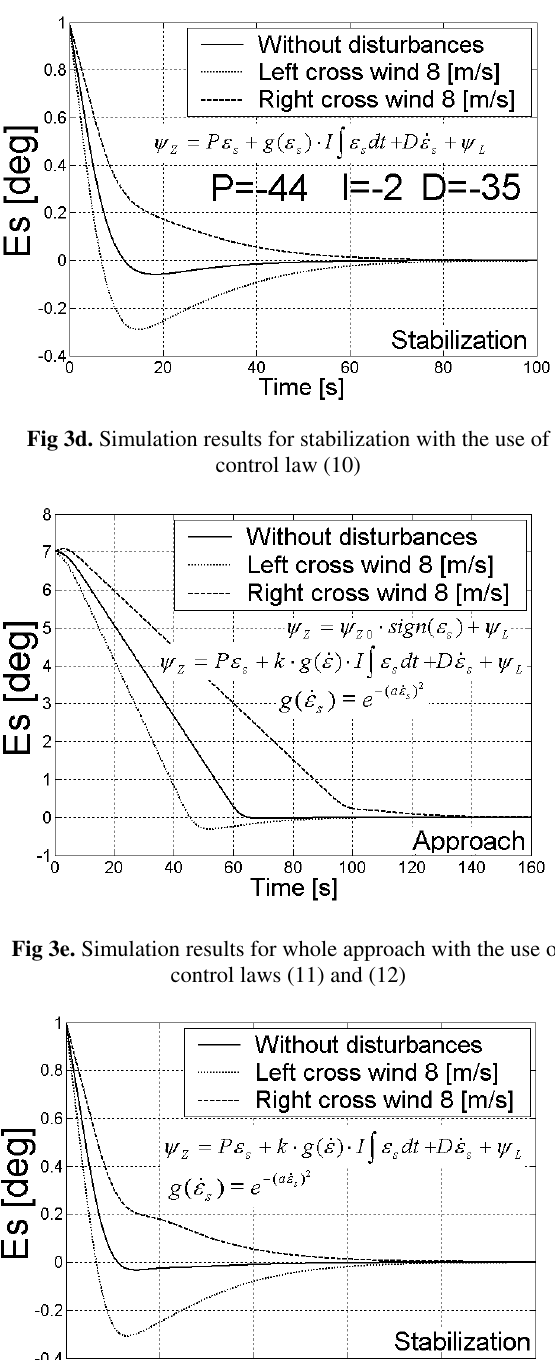
Fig 3f. Simulation results for stabilization with the use of control law (12)